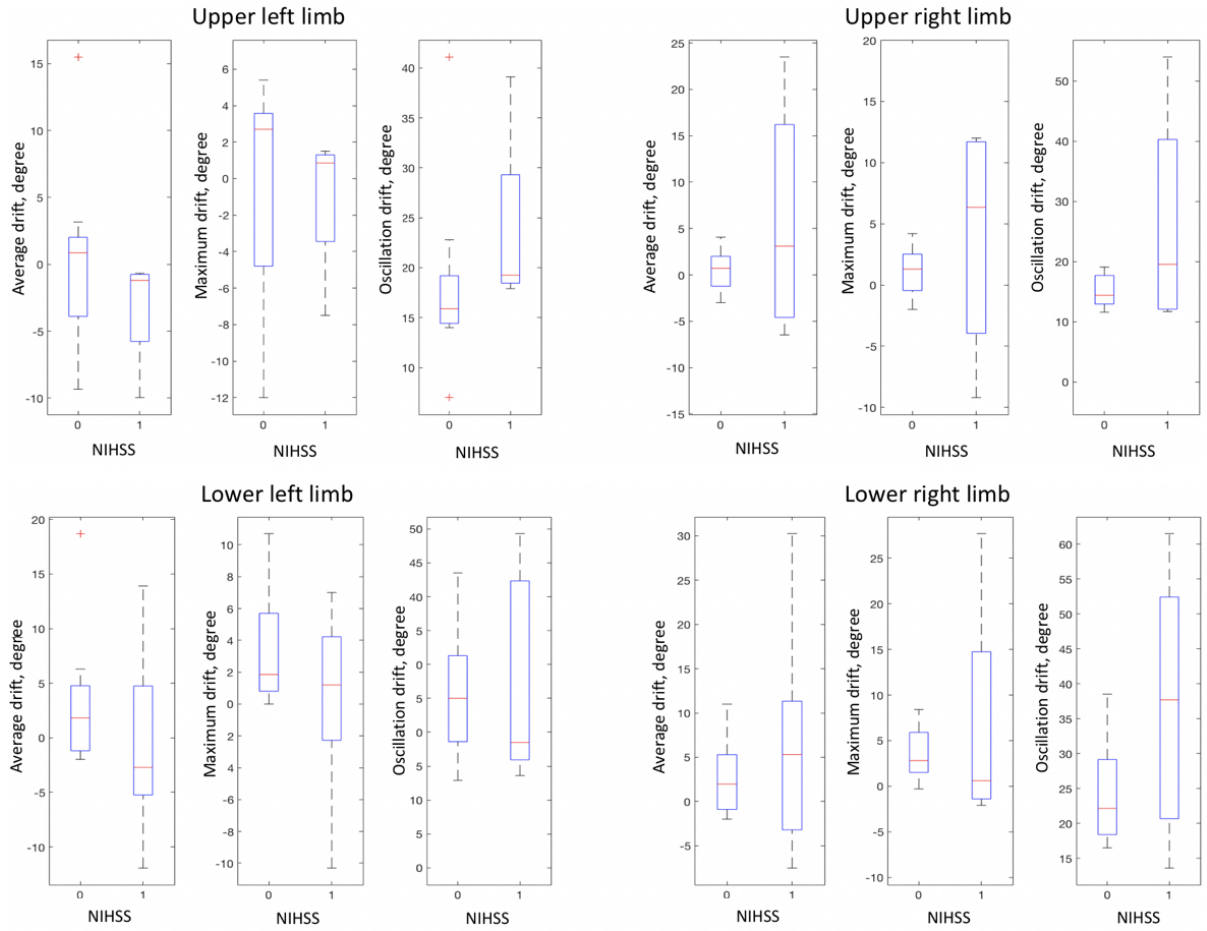
Figure 5. Statistical plots of 4-limb features of NIHSS grades. NIHSS: National Institutes of Health Stroke